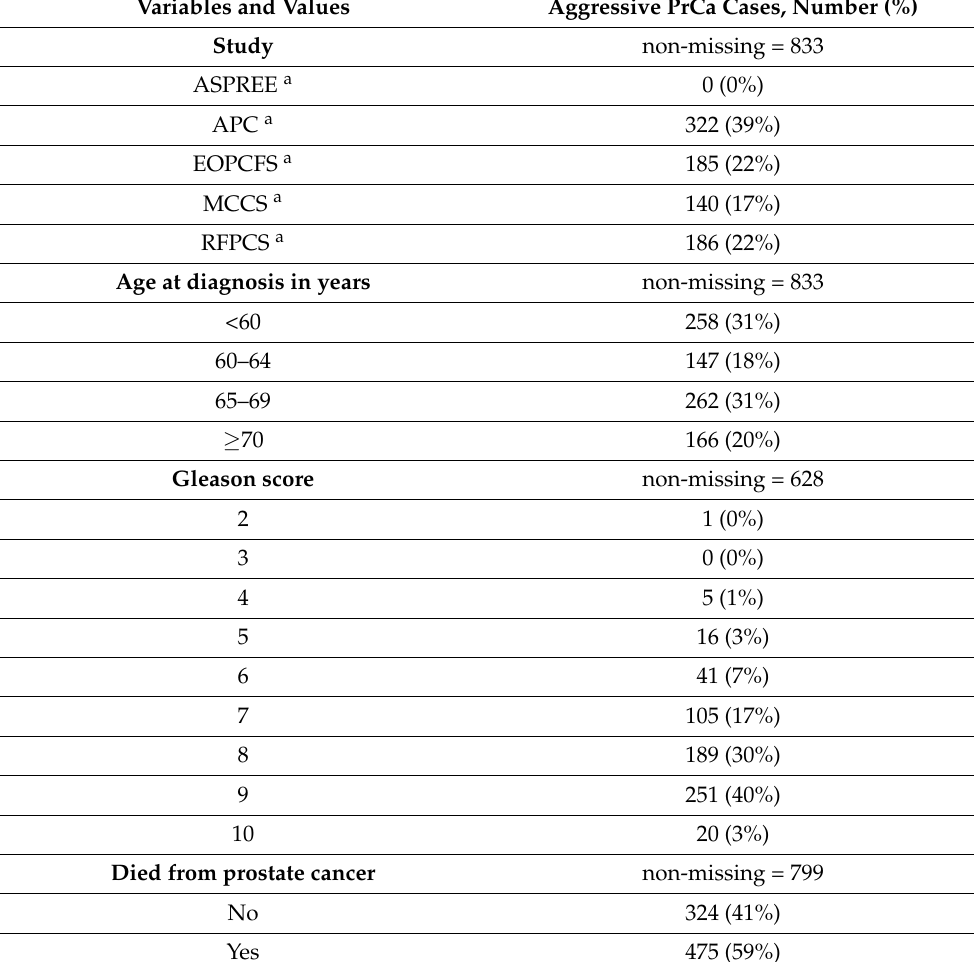
Table 1. Characteristics of the men diagnosed with aggressive prostate cancer who were included in this